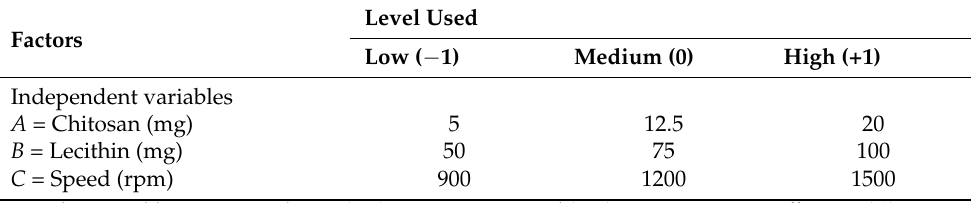
Table 1. Independent and dependent variables in the optimization of CUR/LCSNPs through a Box-Behnken statistical